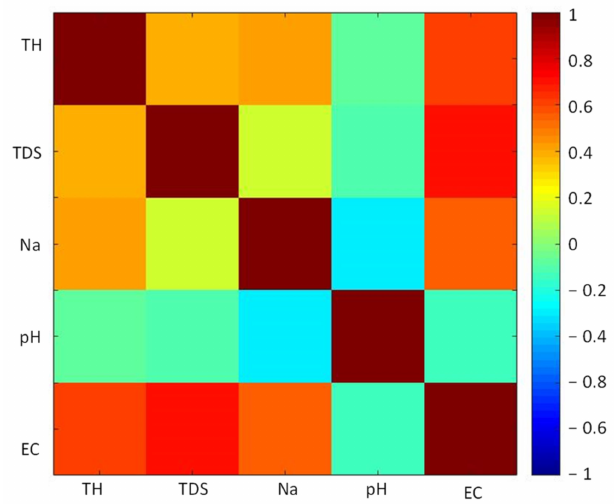
Figure 5. Bivariate correlation between experimental sample data included in matrix X ∗ .